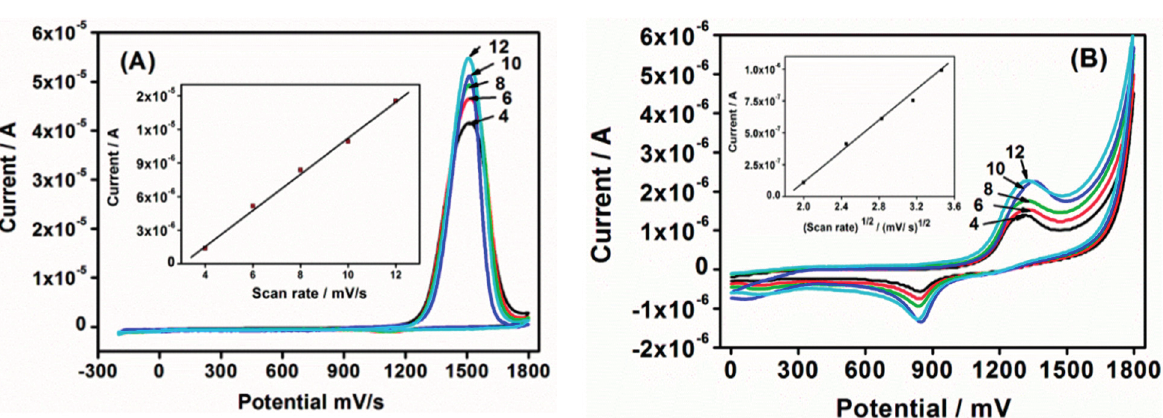
Figure 3. CV voltammograms ( A ) Scan rate dependence of Au|G3PPT-co-P3HT sensor recorded in the absence of PHE in 0.1 mol/L Bu 4 NClO 4 /CH 3 CN; ( B ) The CV scan rate dependence in the presence 3.0 × 10 –3 µmol/L PHE in 0.1 mol/L Bu 4 NClO 4 /CH 3 CN/H 2 O, (numbers on the diagrams are scan rate